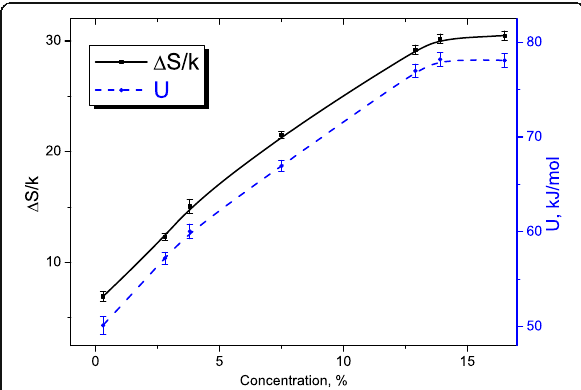
Fig. 14 Dependencies of the entropy and the activation energy of relaxation process on water concentration in MCC.